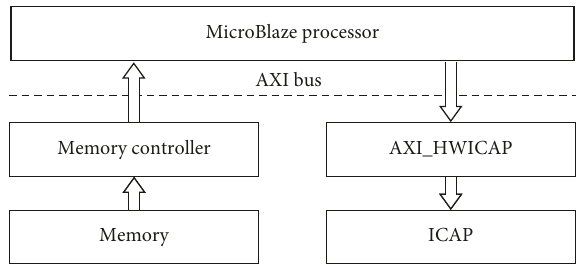
Figure 1: Exemplary structure of a microprocessor-based DPR system using the HWICAP solution by